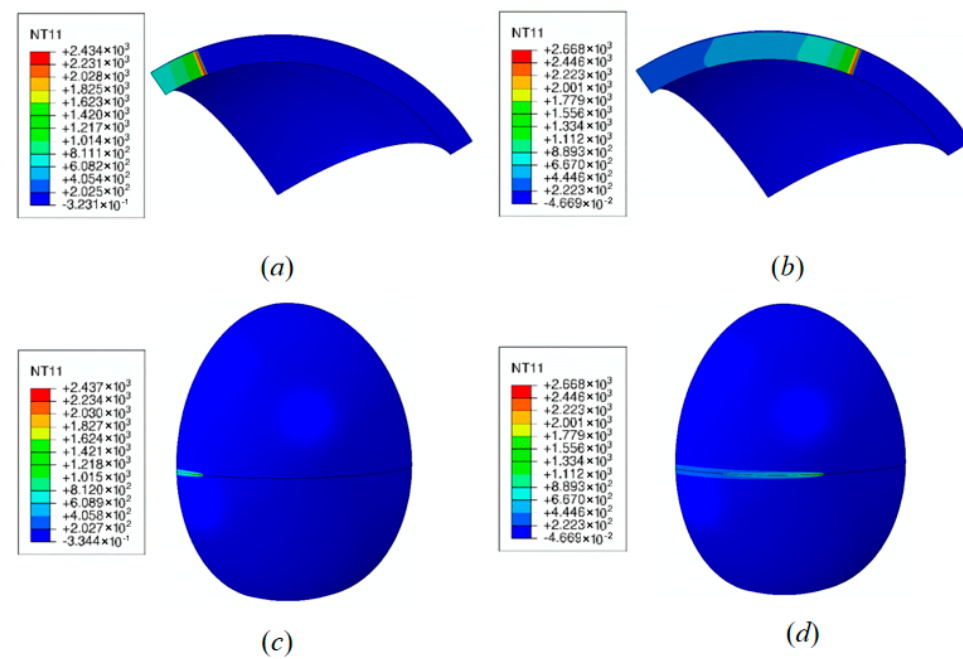
Figure 15. Temperature fields of ( a ) weld section when t = 4 s, ( b ) weld section when t = 12 s, ( c ) spherical pressure hull when t = 4 s, and ( d ) spherical pressure hull when t = 12 s.